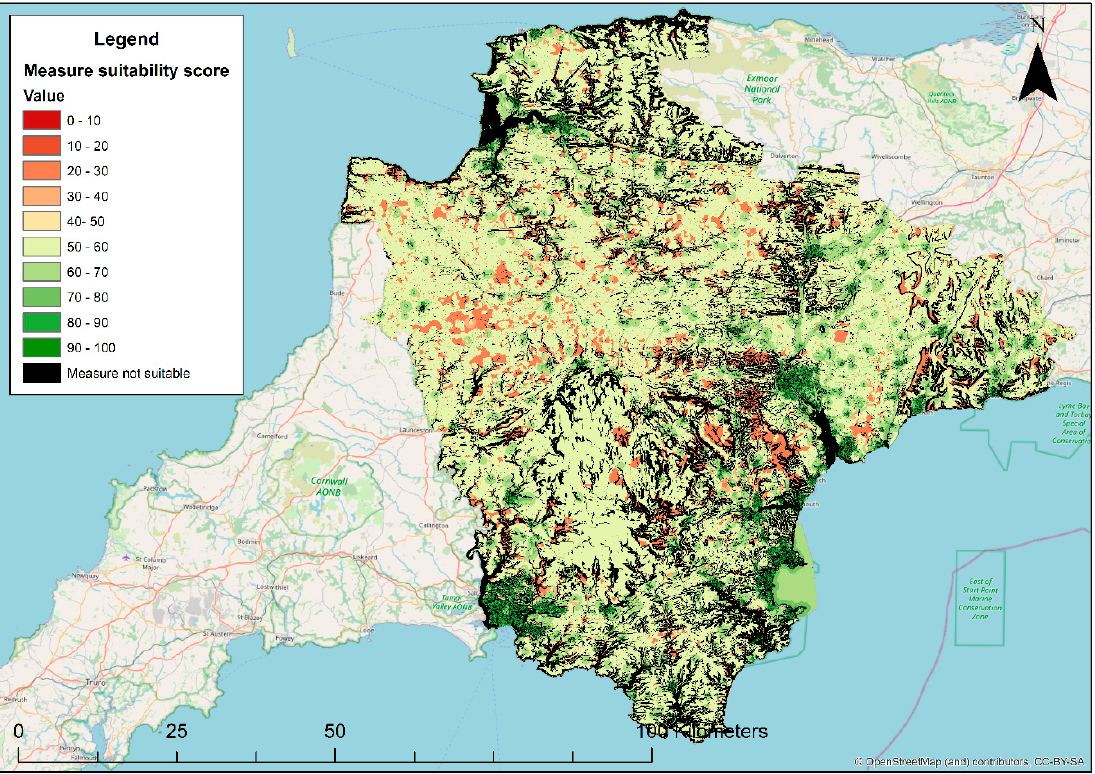
Figure 3. Needs map showing requirement for the benefits of bioretention and rain gardens in Devon .